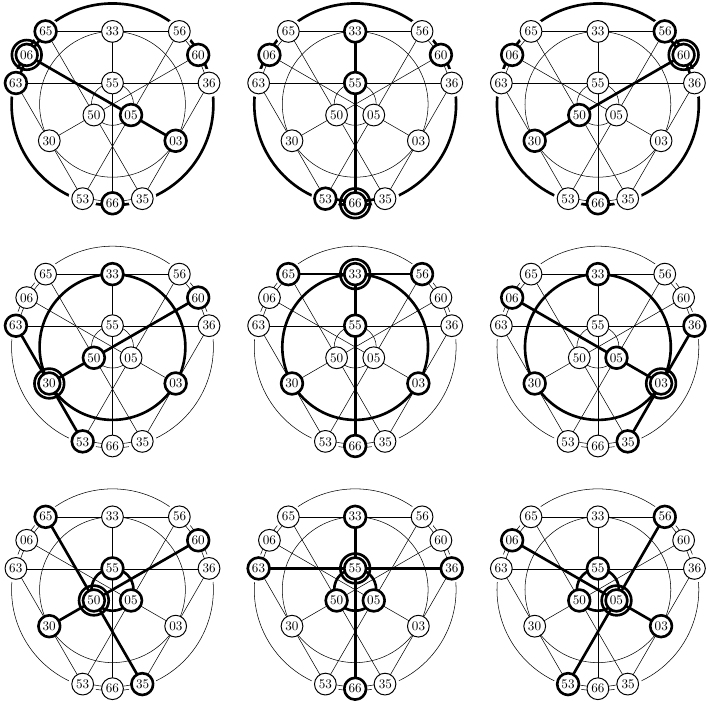
Figure 2. A graphical illustration of “Jacobson traces” of individual non-unimodular free cyclic submodules in the core doily; consecutively from top left to bottom right, they are shown the traces of R ( 6,8 ) , R ( 8,14 ) , R ( 8,6 ) , R ( 8,3 ) , R ( 8,11 ) , R ( 3,8 ) , R ( 8,5 ) , R ( 8,13 ) , and R ( 5,8 ) . In each subfigure, the corresponding concurrent lines are shown in boldface, the point of concurrence being